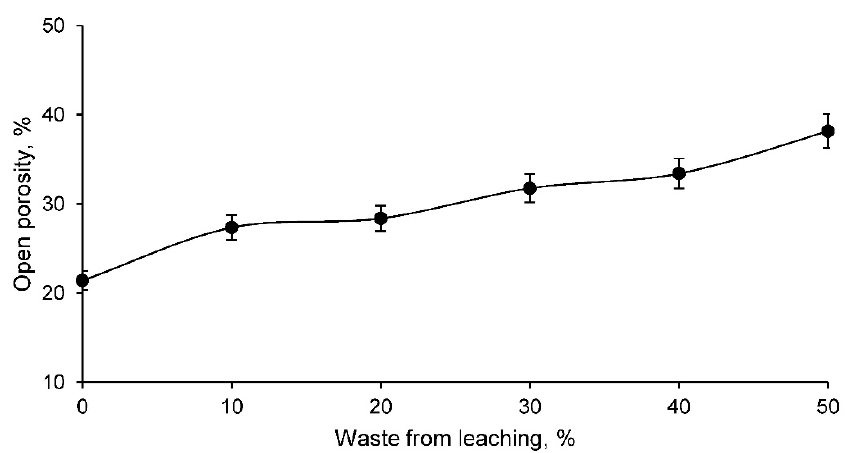
Figure 8. Open porosity of different clay-conformed ceramics families and leaching residue.